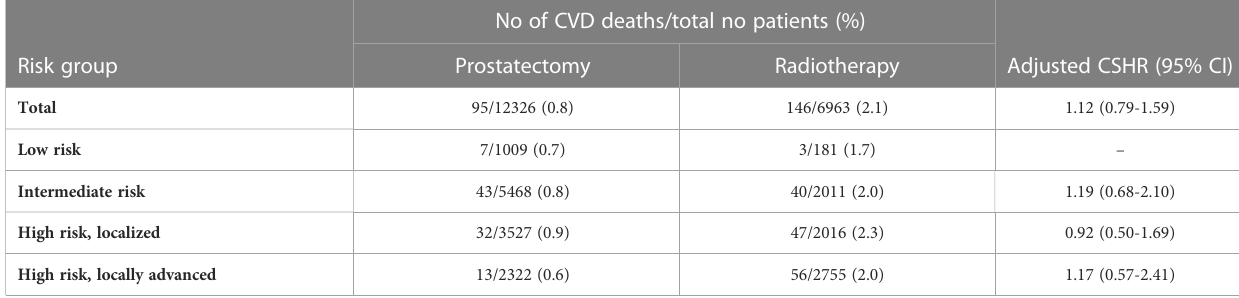
TABLE 3 Cardiovascular deaths and cause-speci fi c hazard ratios (aCSHR) comparing radiotherapy to prostatectomy (reference). .